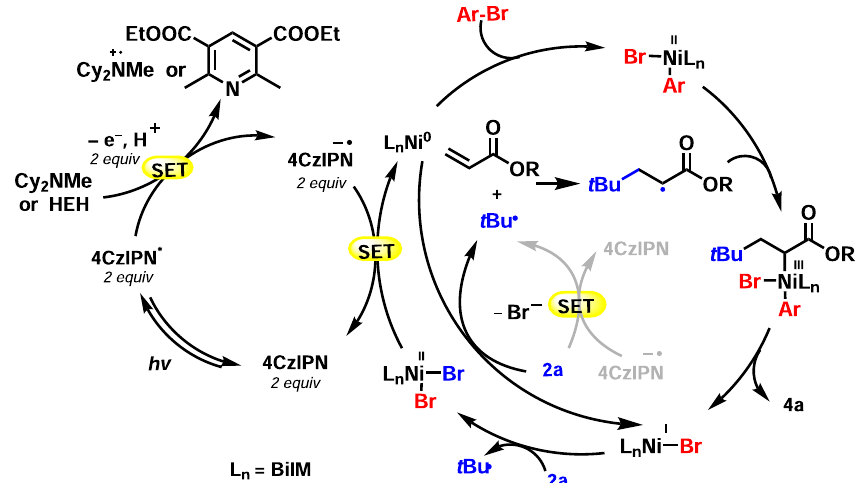
Fig. 3 Plausible catalytic reaction pathway. Key steps include oxidative addition of Ar – Br to Ni(0), radical generation by SET from nickel to the alkyl bromide, Giese addition of the alkyl radical to the acrylate, trapping of the α -carbonyl radical by Ni(II) to give Ni(III), which undergoes reductive elimination to give the product. The photocatalytic cycle involves reduction of 4CzIPN to 4CzIPN – , which is proposed to reduce the Ni catalyst to solution turned from light green to yellow. The vial was sealed with a cap and removed from the glove box. The reaction mixture was stirred at RT under blue light. After 24h, the color of the solution changed back to light green. The vial was opened to air and EtOAc (10mL) was added to the solution, which was then washed with brine